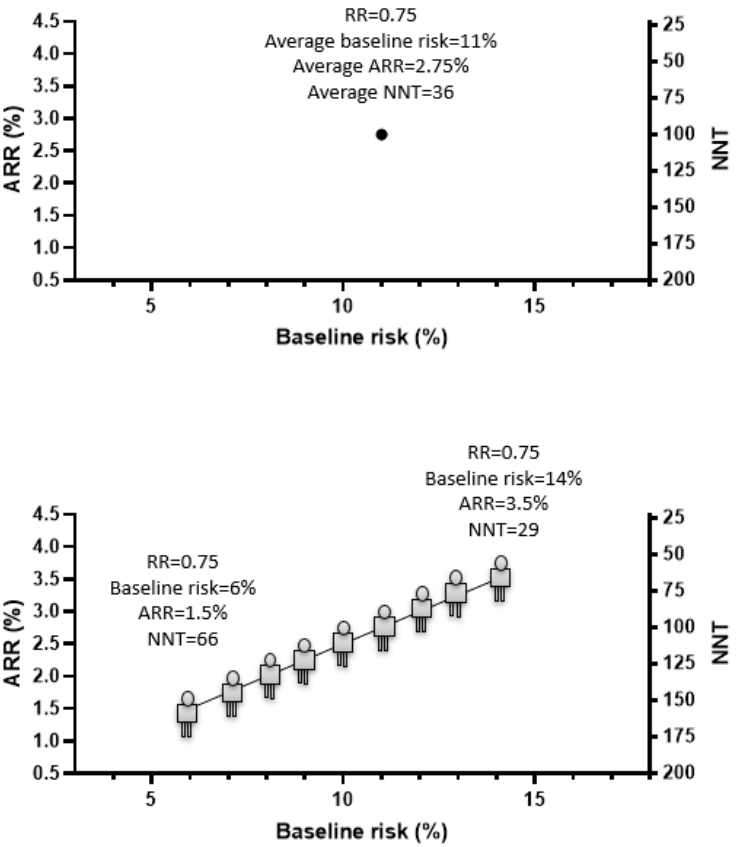
Figure 2. Graphical representation of precision medicine approaches improving clinical benefit of an intervention through identification of subgroup of subjects with a larger baseline risk of the disease of interest.